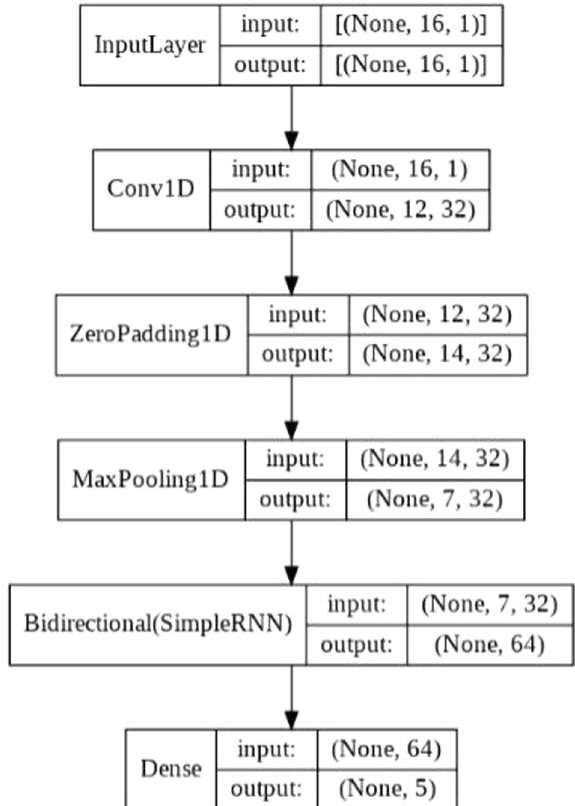
RNN architecture +